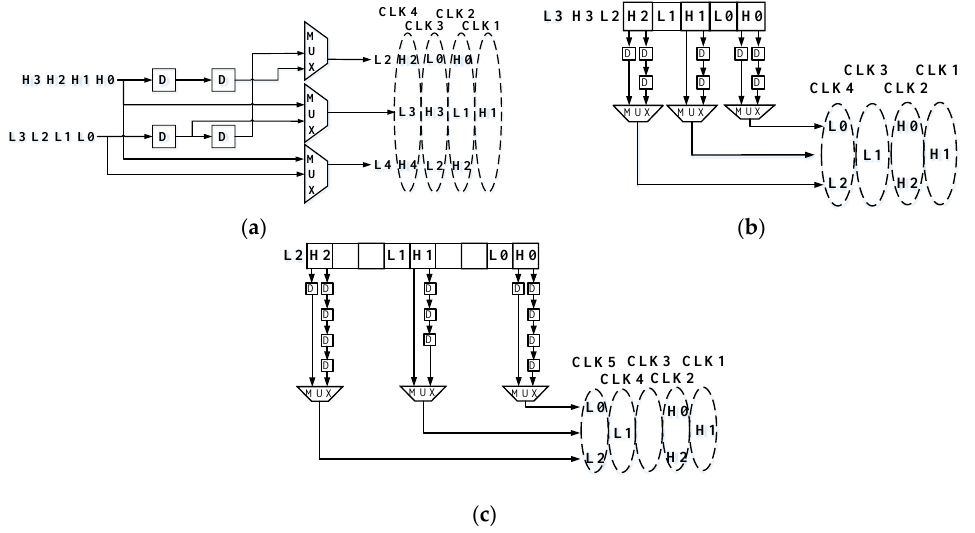
Figure 8. Structure of the transposing module and the orders of the input and output. ( a ) For the condition of 1:1 clock-to-data ratio. ( b ) For the condition of 2:1 clock-to-data ratio. ( c ) For the condition of 4:1 clock-to-data ratio.